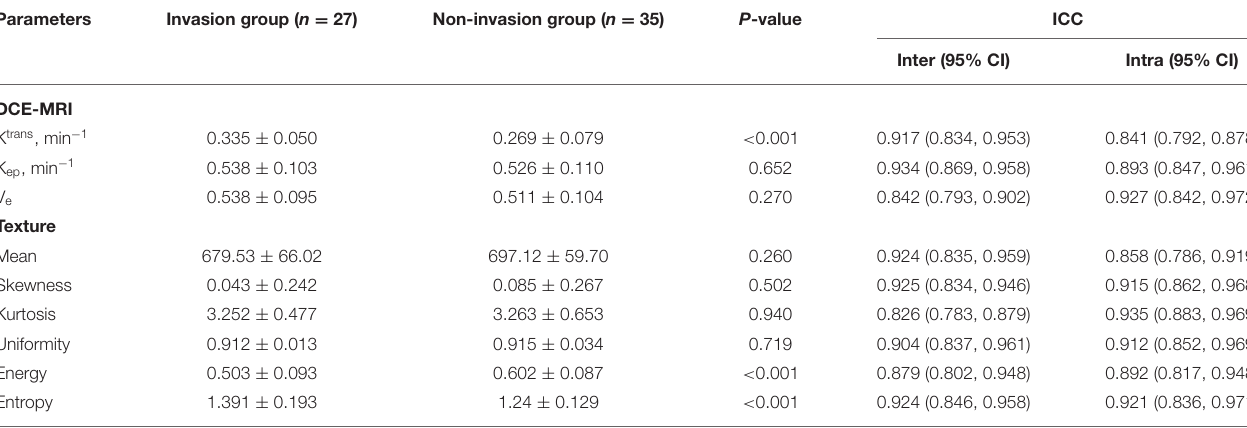
TABLE 1 | Comparison of DCE-MRI and texture feature derived parameters. Parameters